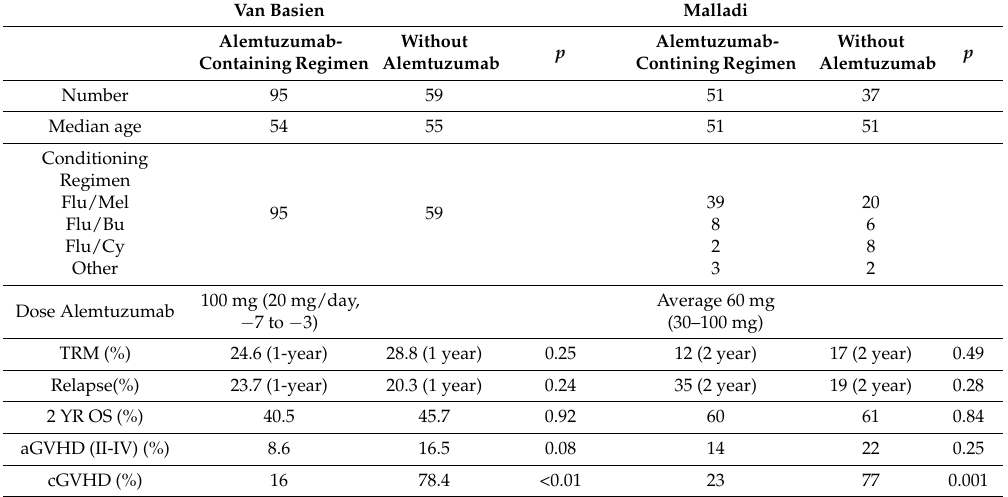
Table 3. Comparison of studies performed by van Basien and Malladi, assessing the benefit adding alemtuzumab to standard conditioning